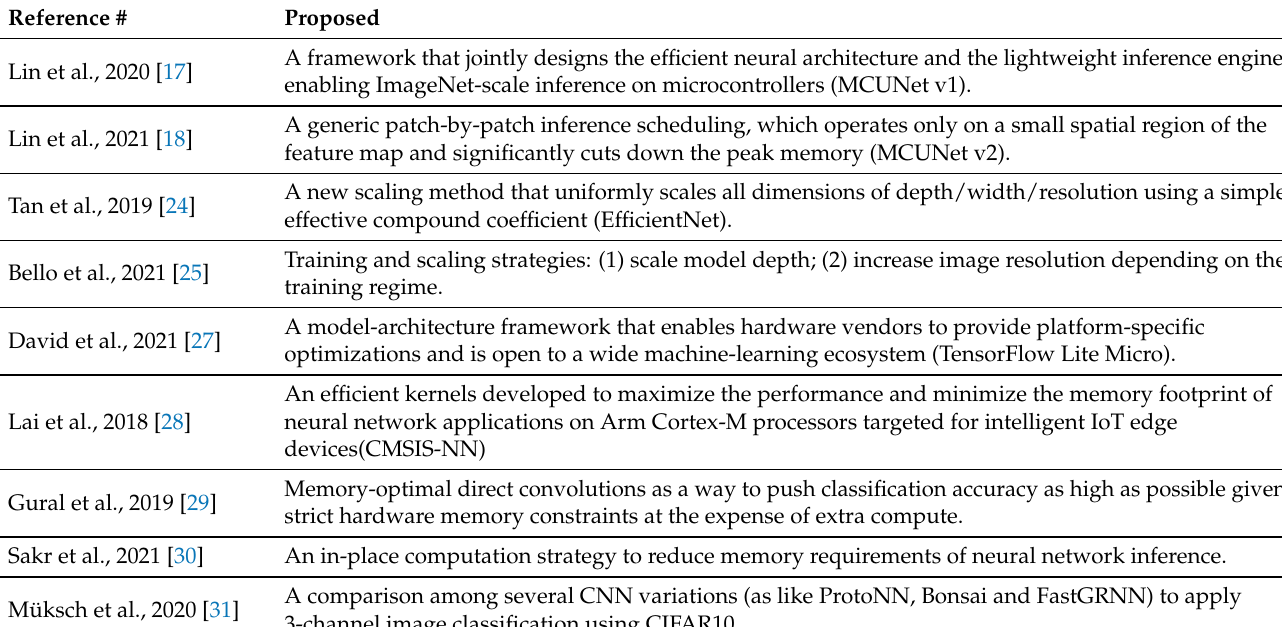
Table 1. Summary of the related